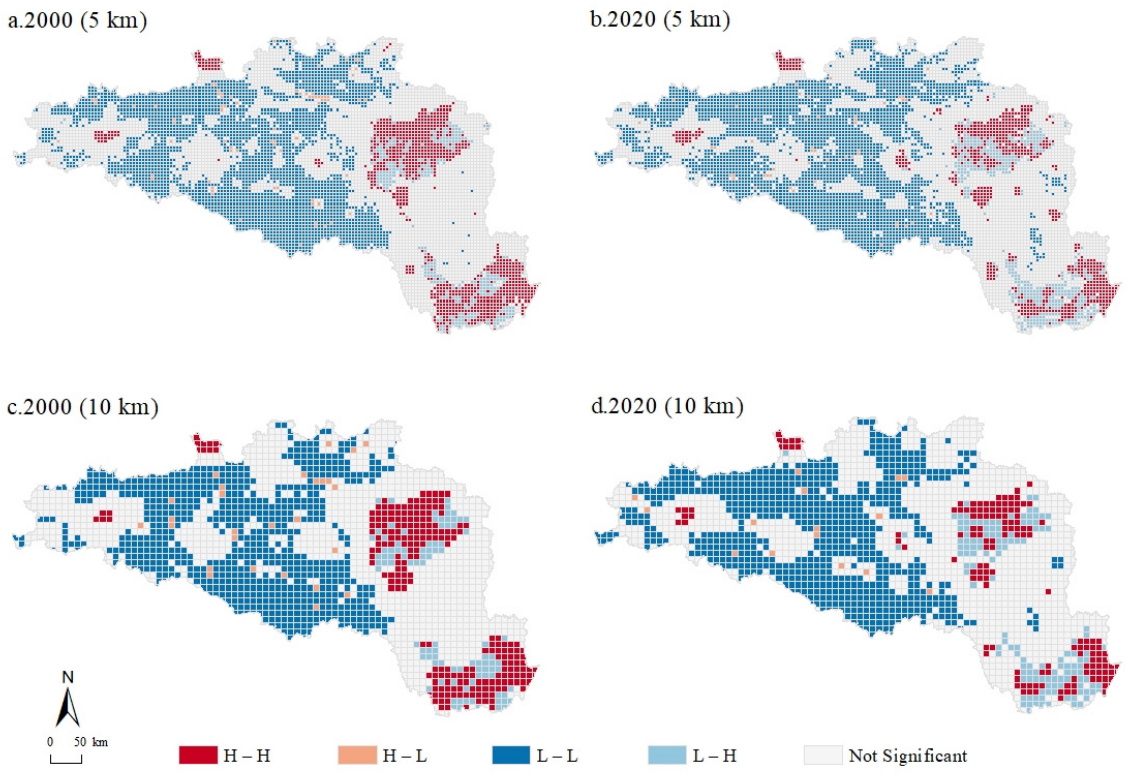
Figure 4. LISA maps of urbanization elements and ESBI at the 5 km grid scale in the HREEB in China.